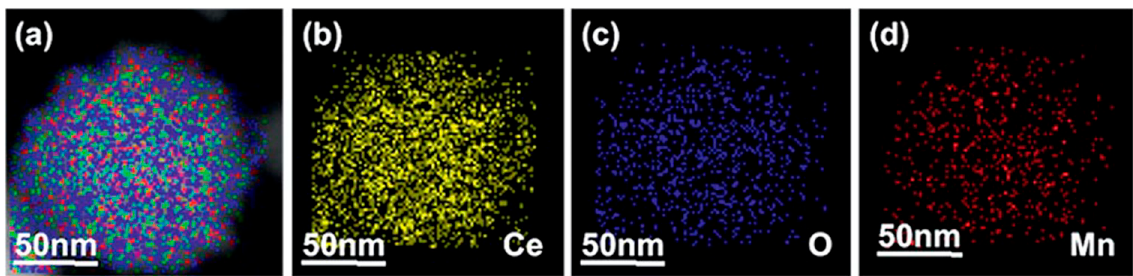
Figure 5. Energy-dispersive spectroscopy maps of a 7% Mn-substituted ceria nanosphere [63]. ( a ) shows an overlay of signals from all elements and ( b )–( d ) show the signals from individual elements. Reproduced with permission of John Wiley and Sons.